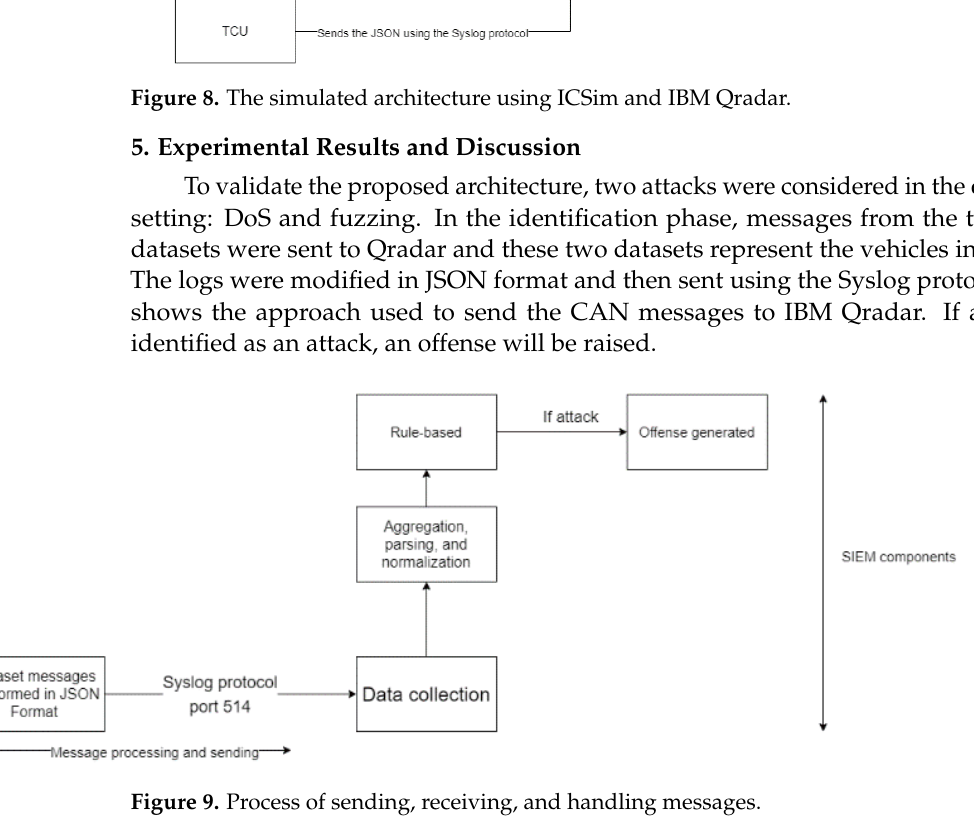
Figure 9. Process of sending, receiving, and handling messages.